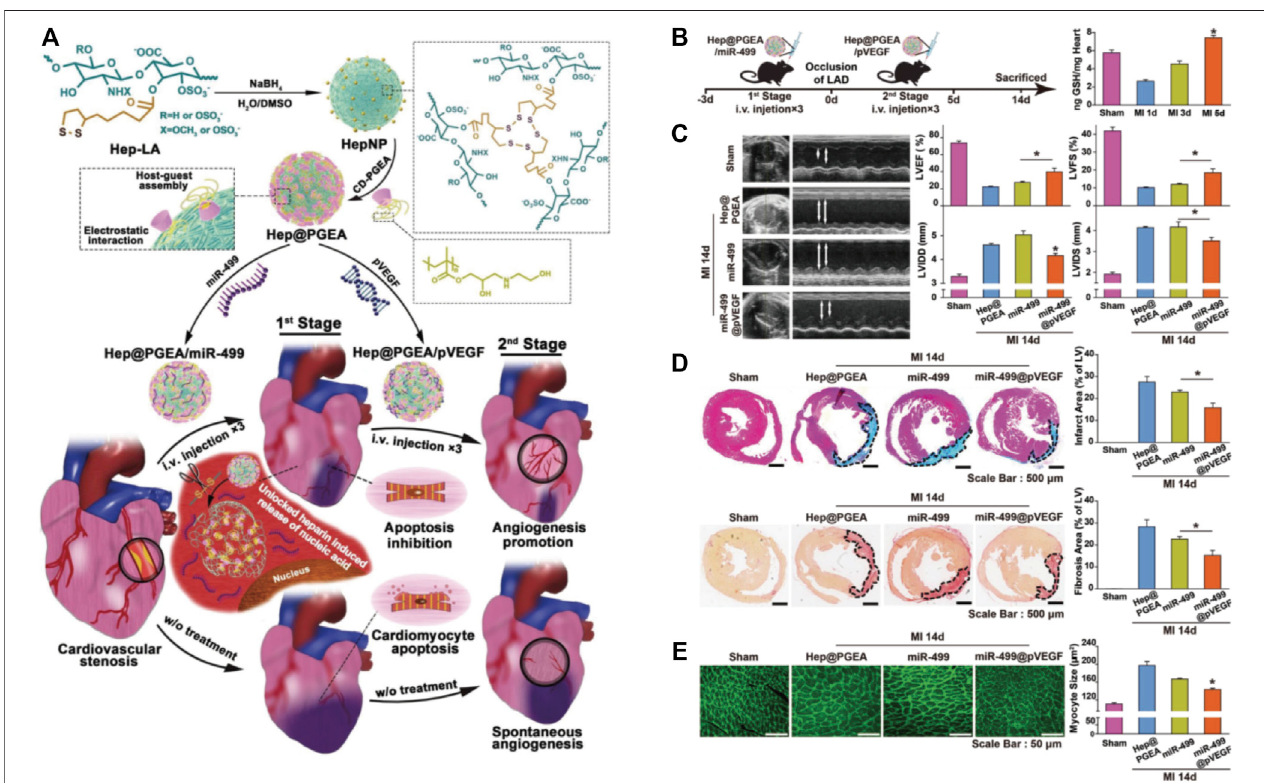
FIGURE 4 | The application of nanomaterials for the delivery of miRNA and pDNA to inhibit the cardiomyocytes apoptosis in MI. (A) Schematic illustration of the construction of unlockable heparin core-shell nanocomplexes (Hep@PGEA) and their applications in the delivery of miRNA and pDNA for the treatment of MI. (B) The timeaxisofthisstudyand theevaluation ofGSH amountinmouseheartsatdifferenttime pointsafterMI. (C) Hep@PGEA preservedthecardiac functionofmiceafter MI evaluated by M-mode echocardiograms. (D) The delivery of Hep@PGEA reduced the infarct areas and fi brosis areas re fl ected by quanti fi cation of Masson trichrome and Red Sirius staining. (E) Hep@PGEA inhibited the cardiomyocytes hypertrophy re fl ected by the WGA staining. Adapted with permission from Nie et al., 2018.